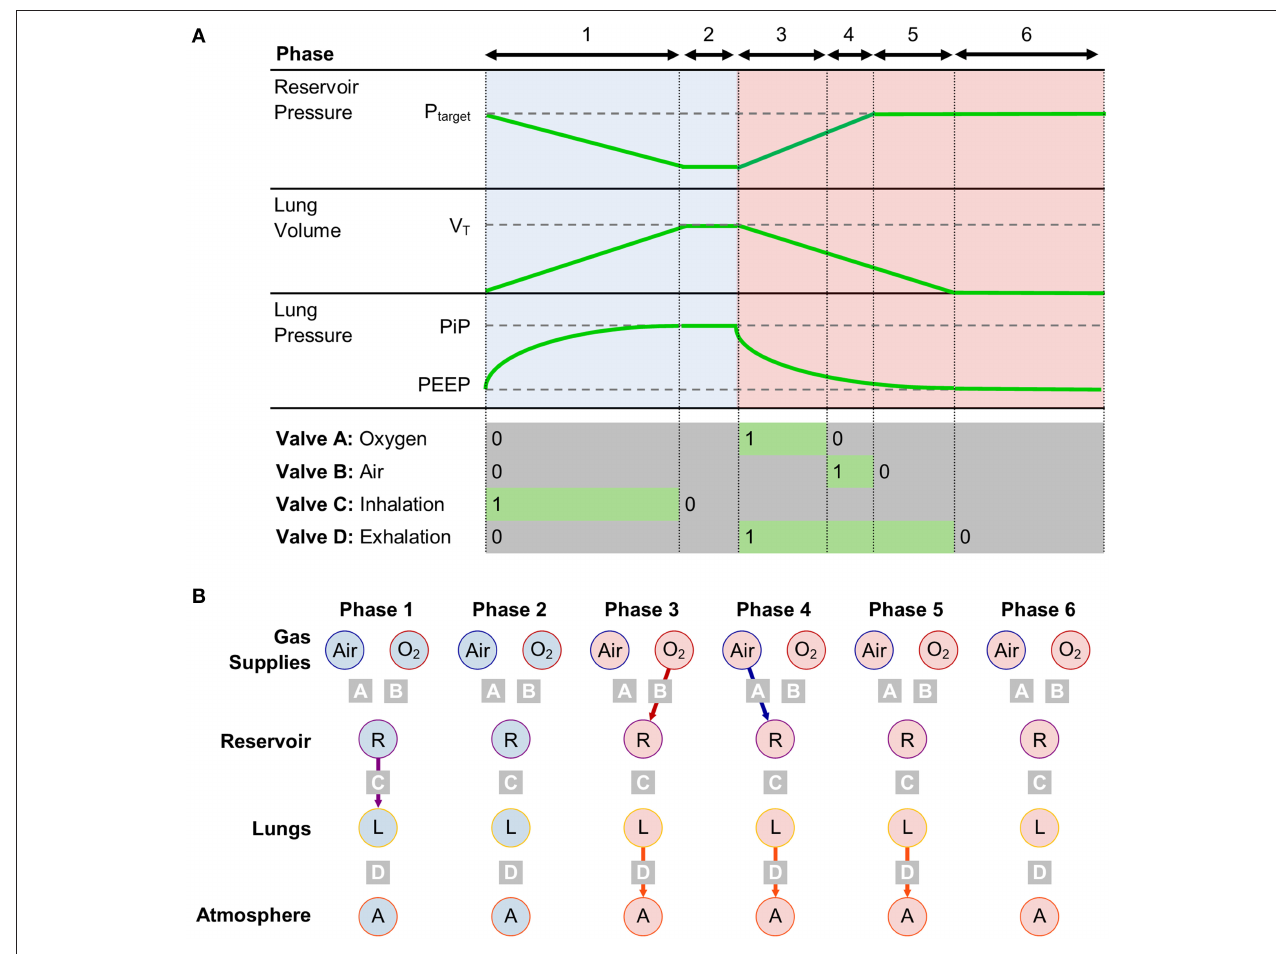
FIGURE 2 | (A) Timing diagram for operation in PRVC mode, separated into 6 phases, with corresponding valve states and key system parameters. (B) Compartment model showing connections between gas storing components in each